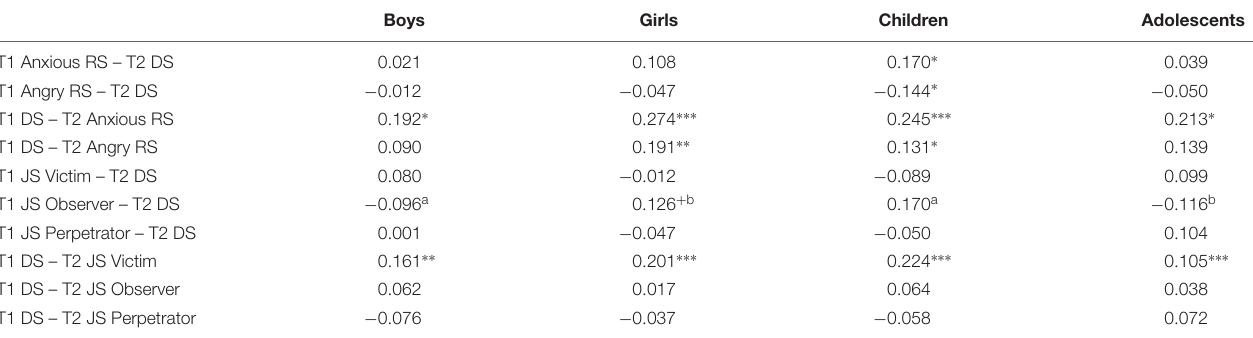
TABLE 3 | Path weights from the multi-group models controlling for differential links of the rejection sensitivity and the justice sensitivity scales with depressive symptoms as moderated by gender and age, respectively. Boys Girls